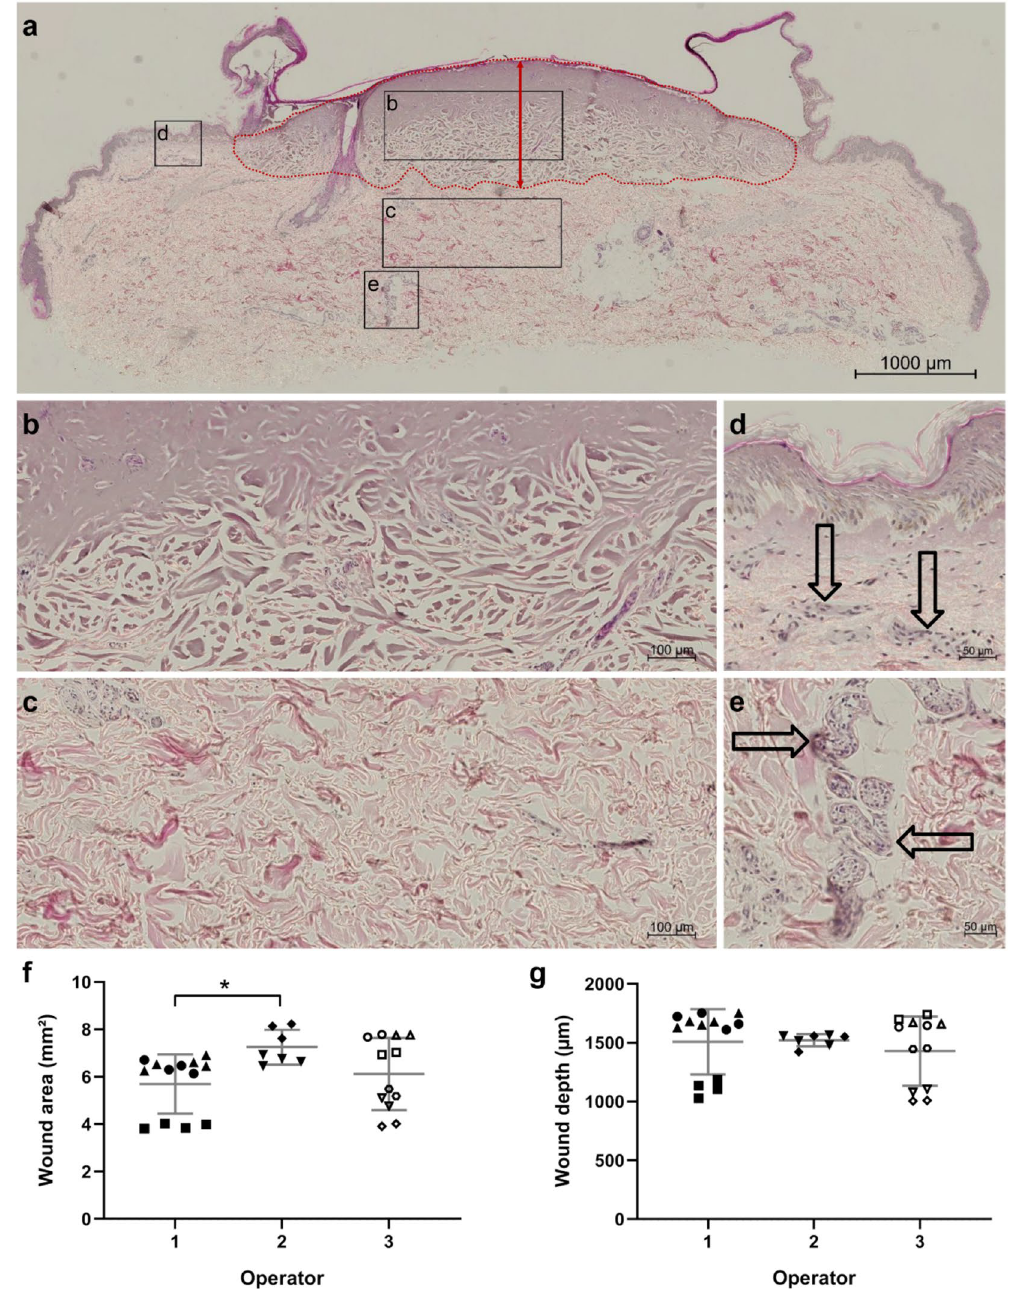
Figure 2. Microscopic evidence and quantification of burn injury (300 °C, 15 s). An H&E stained section of a burned skin tissue (burned, non-debrided, non-infected, no neutrophil supplementation) fixed one day post- burn wound induction (( a ); N = 3, n = 6, representative image is shown). Cell nuclei are stained dark blue while extracellular structures are pink. Red dotted line shows the border of the burn wound as used to calculate the area of damage and the red arrow indicates the depth of the burn. Disrupted collagen structure within the burn wound ( b ) can be compared to the normal collagen structure of the lower dermis ( c ). Presence of immune cells is indicated by arrows in the upper dermis ( d ) and within glands in the subdermal tissue ( e ). Three different operators burned single skin tissue pieces (( f , g ); operator 1: N = 3, operator 2: N = 2, operator 3: N = 6; black filled square, open circle etc.: each symbol represents one skin tissue piece). Multiple sections were quantified by various analyzers (operator 1: n = 13, operator 2: n = 7, operator 3: n = 12). Quantification of wound area and depth by various operators is similar as all single dots per skin sample cluster together. Burn wound induction by various operators is well reproducible as indicated by wound area ( f ) and depth ( g ), although there is a slightly larger wound area induced by operator 2. N = number of skin tissue pieces, n = number of technical replicates (skin tissue sections), One-way ANOVA with Tukey’s post-hoc test, asterisk represents significant difference between operators, *p <